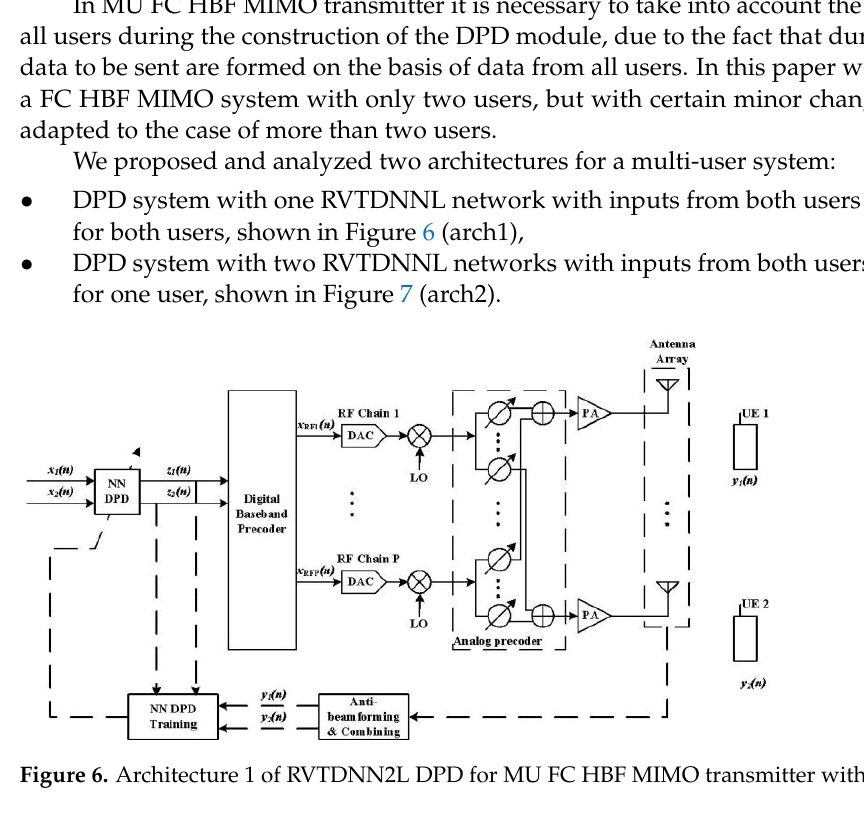
Figure 7. Architecture 2 of RVTDNN2L DPD for MU FC HBF MIMO transmitter with two NNs. Levenberg-Marquardt optimization algorithm was applied for training RVTDNN2L. Tansig activation function was used in both hidden layers. We tested model with different number of neurons in hidden layers of network and proposed the optimal number to ob- tain the best performance. Graphics and tables are given for three combinations of num- bers of neurons in hidden layers, i.e., for I = 18 neurons in the first hidden layer and II = 9 neurons in the second hidden layer; I = 32 neurons in the first hidden layer and II = 15 neurons in the second hidden layer; and I = 48 neurons in the first hidden layer and II = 21 neurons in the second hidden layer. As for SU FC HBF MIMO, a clustered Saleh-Valen- zuela channel model is adopted. For MU FC HBF MIMO, the model contains N cl = 6 clus- ters, with N ray = 10 rays in each cluster. For the scheme in Figure 6, the proposed RVTDNN2L DPD model with 4 inputs and 4 outputs was used, i.e., we considered I and Q components of signals from both users, both inputs and outputs. While for the scheme in Figure 7, the proposed RVTDNN2L DPD model has two NNs, one for each user, both with 4 inputs and 2 outputs, i.e., we considered I and Q components of output signals from both users, and I and Q components of input signals for specific user. The same PA model as for the SU case was used. Two 64 QAM modulate OFDM signals with a bandwidth of 20 MHz were generated in Matlab. Simulations of a 64 × 64 FC HBF MIMO system, with 2 users and 2 RF chains were performed, for both architec- tures shown in Figures 6 and 7. Figures 8 and 9 show obtained power spectrum densities (PSDs) without DPD and with proposed RVTDNN2L DPD model for both types of architecture. While Tables 4 and 5 summarize the performance of the proposed RVTDNN2L DPD models for each user